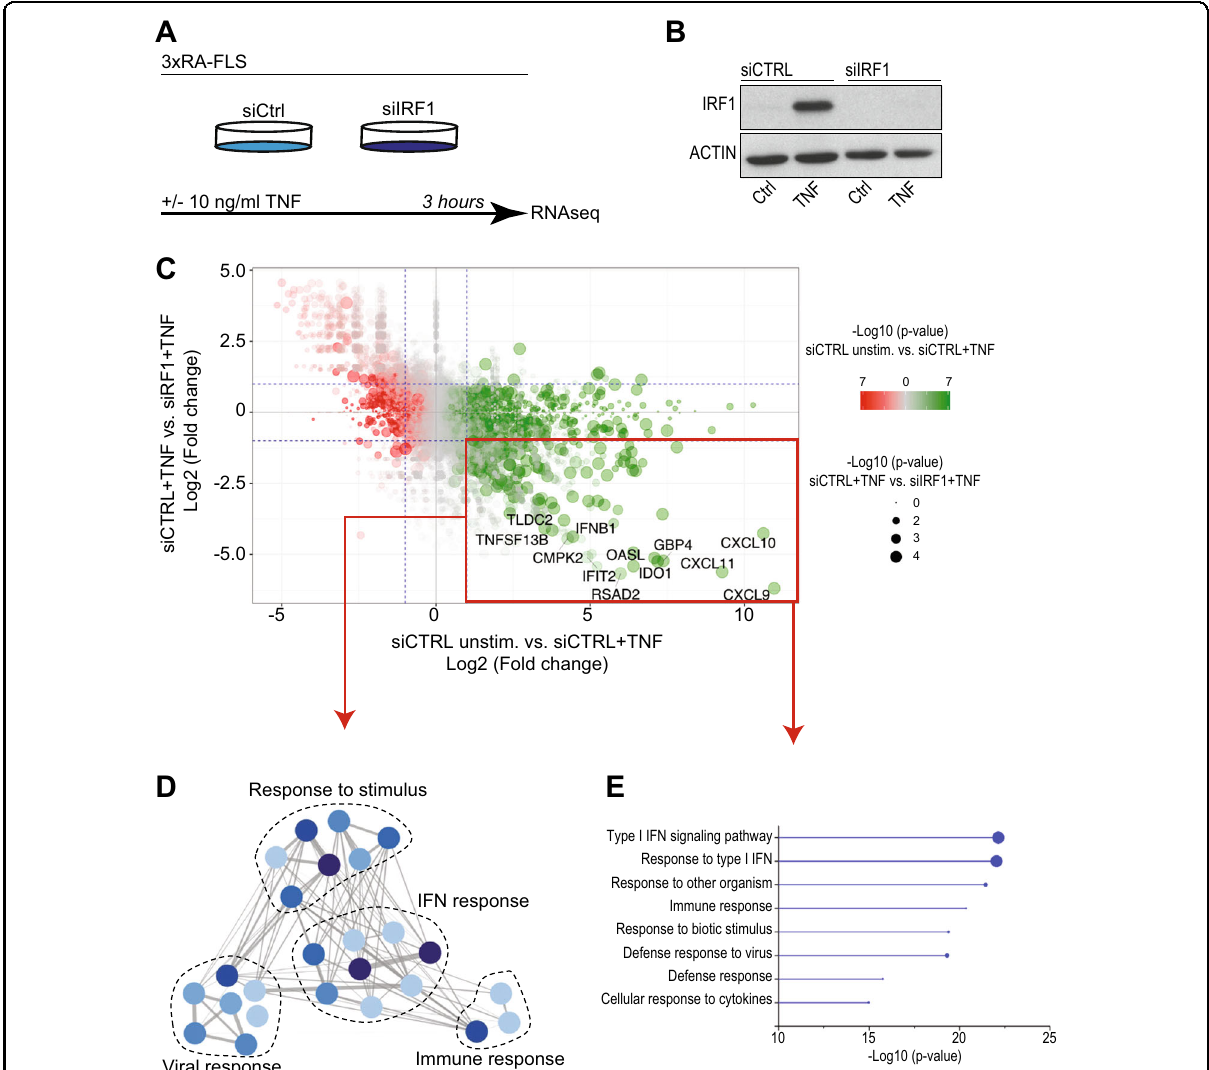
Fig. 2 The TNF-driven interferon response in FLSs depends on IRF1. a Work fl ow outlining the RNA sequencing (RNA-seq) experiment. RA-FLSs from three different RA patients were transfected with nontargeting (siCTRL) or IRF1-targeting siRNA pools and stimulated with TNF (10 ng/ml) for 3 h. RNA was isolated and processed for transcriptomic pro fi ling. b Representative immunoblots of IRF1 expression in RA-FLSs after siRNA transfection and stimulation with TNF (10 ng/ml) for 3 h. c Scatter-plot of the RNA-seq data (panel A) showing the impact of IRF1 knockdown on TNF-regulated genes. Dots in the lower right quadrant (red box) represent genes with expression upregulated by TNF, but impaired by the siRNA-mediated knockdown of IRF1 expression. Dashed blue lines indicate a twofold change in gene expression. d Network analysis of GO term (biological process, BP) enrichment among signi fi cantly regulated TNF-IRF1-dependent genes (as depicted in panel C, red box). The resulting network was calculated and visualized using EnrichmentMap. Groups of similar GO terms were manually circled. Line thickness is proportional to the similarity coef fi cient between the connected nodes. Node color is proportional to the FDR-adjusted P -value of the enrichment. e Enriched GO terms (BP, top 8) of the genes within the bottom right quadrant (red box) in the scatter-plot (Fig. 2c). Circle size shows the relative amount of signi fi cant genes associated with the GO